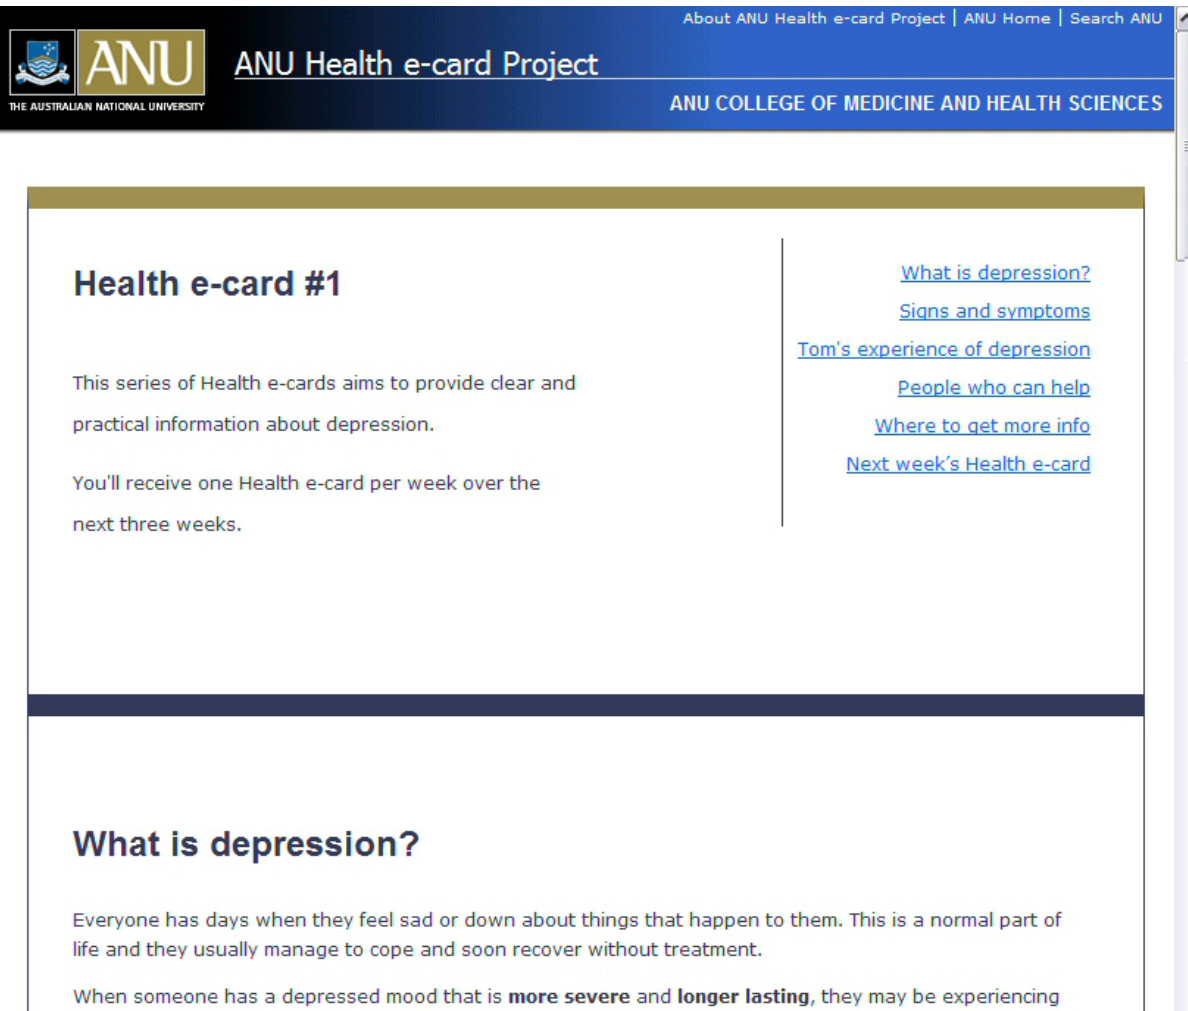
Figure 2. Screenshot of a health